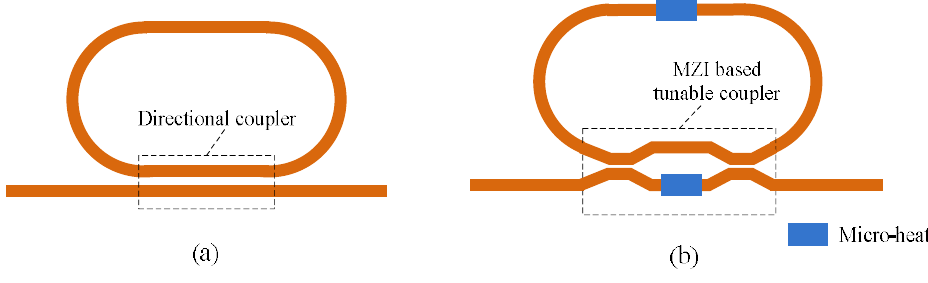
Figure 15. Schematic structures of the microring resonators consisting of ( a ) a directional coupler and ( b ) a MZI based tunable coupler.